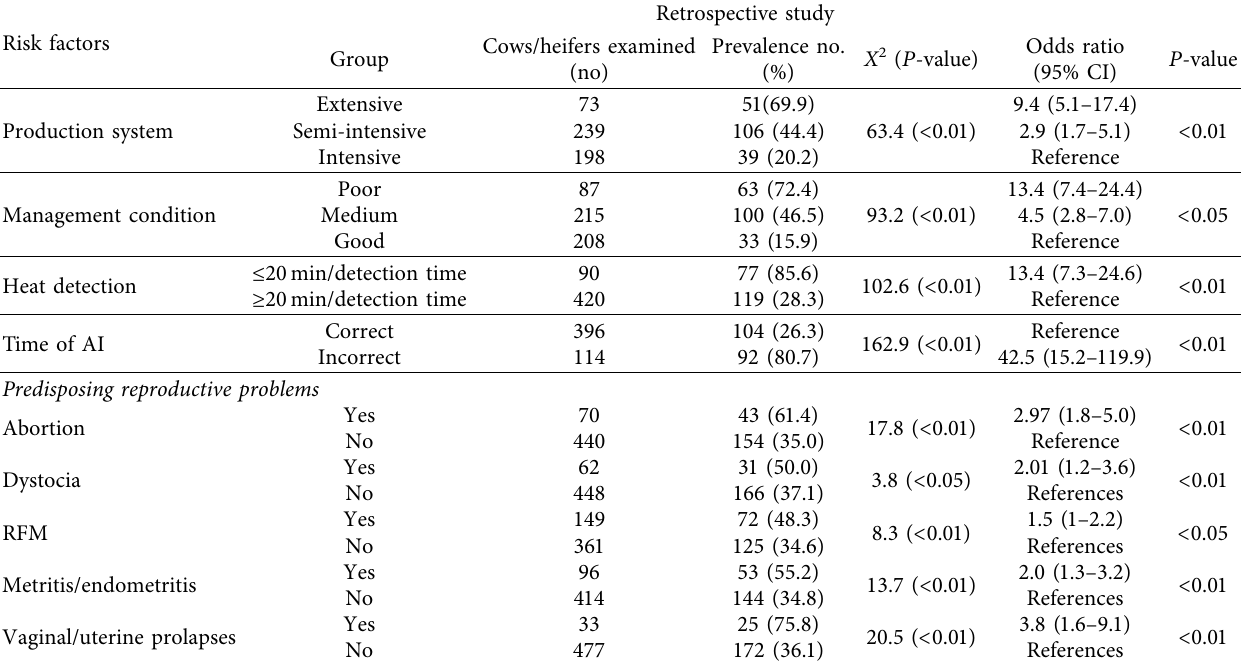
Table 3: Prevalence of repeat breeding across with production system, feeding management, heat detection, time of AI, and predisposing reproductive problems) in crossbred dairy